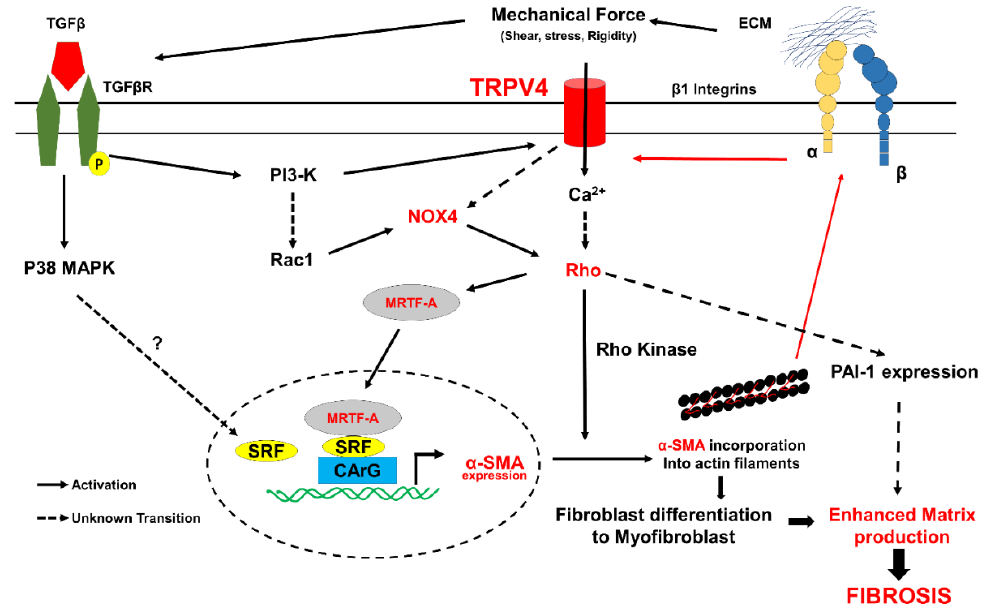
Figure 5. TRPV4 integrates soluble and mechanical signaling during fibroblast differentiation to myofibroblast. TRPV4 senses mechanical forces and activates Rho/Rho kinase pathway. Rho/Rho kinase dependent polymerization of actin releases MRTF-A from actin monomers, which then translocates into nucleus and induces α -SMA expression by binding with CArG sequences together with SRF. Rho/Rho kinase, on the other hand, enables α -SMA incorporation into the stress fibers, resulting in fibroblast differentiation into myofibroblasts. TGF- β activates PI3K-gamma, which forms complex with TRPV4; the complex is translocated to the plasma membrane and activates calcium influx at the Rho/MRTF-A pathway. TRPV4/TGF- β was also shown to activate NOX4 via PI3K/Rac1, which feeds into Rho pathway. In addition to inducing fibroblast differentiation to myofibroblasts and fibrotic gene expression, Rho/Rho kinase pathway activates PAI-1 expression and inhibits matrix degradation. Myofibroblasts are hypercontractile and apply tensional forces on the ECM and activate integrins, resulting in the release of TGF- β from latent complex inducing a positive feedback loop and enhancing fibroblast differentiation to myofibroblasts, excessive ECM production, and eventually fibrosis. Since, TRPV4 integrates soluble (TGF- β ) and mechanical (integrin/Rho) signaling required for fibroblast differentiation and fibrosis, we propose TRPV4 as the novel therapeutic target for fibrosis.